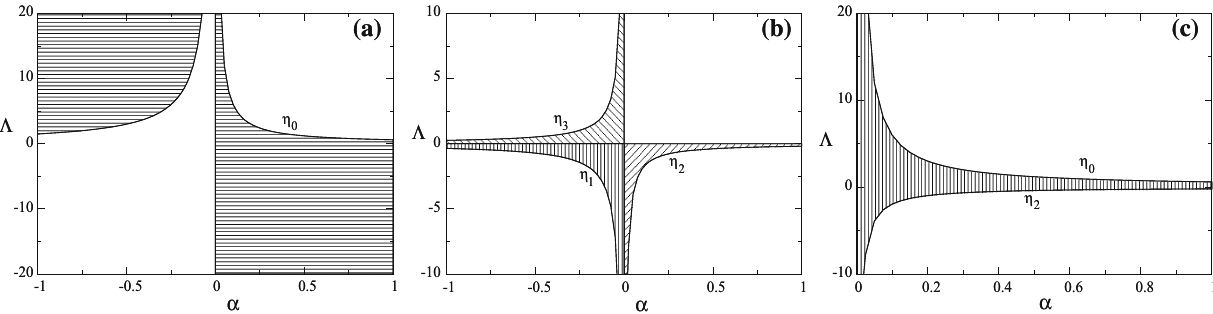
Fig. 6 Summary of the bounds on ( α,(cid:2) ) from this paper alone on a ; from other considerations found in the literature on b and the intersection between them on c (see the text for more